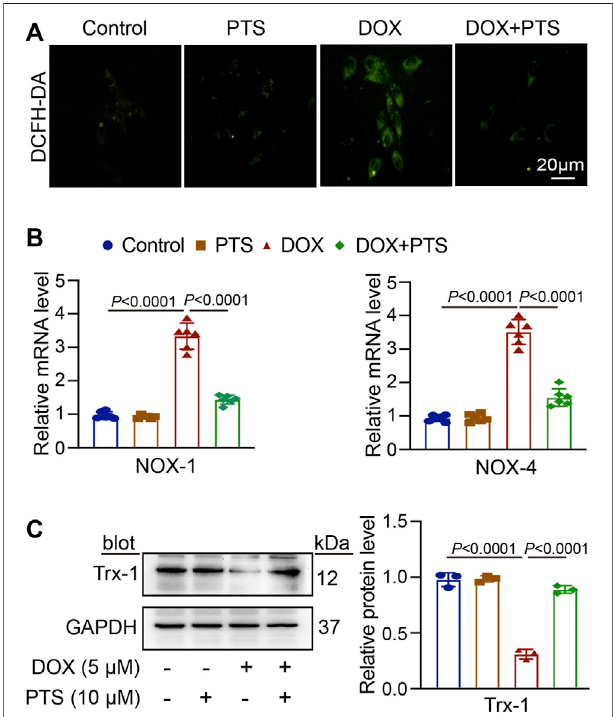
FIGURE 5 | PTS increases the expression of Trx-1 and prevents oxidative damage in DOX-treated HepG2 cells. (A) HepG2 cells were pretreated with PTS (10 μ M) for 4 h and afterwards with DOX (5 μ M) for 24 h. DCFH-DAstainingofeachgroupwasanalyzedtodetectpossibleeffects ofPTSontheROSlevelinDOX-treatedHepG2cells( n =3); (B) PTSeffectson NOX-1 and NOX-4 mRNA levels in DOX-treated HepG2 cells ( n = 6); (C) PTS effects on Trx-1 protein expression in DOX-treated HepG2 cells (left, n = 3), quanti fi cation of Trx-1 protein expression (right, n =